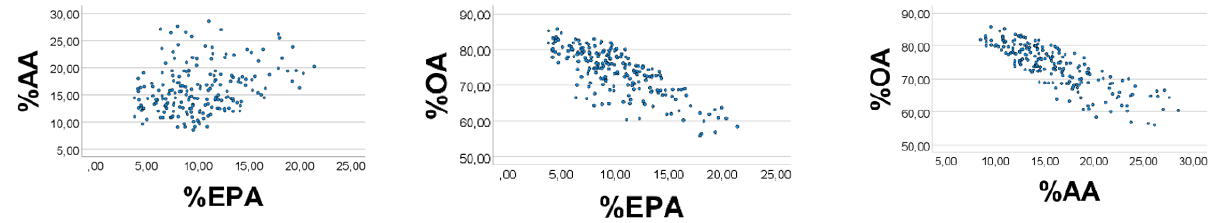
Figure 4. Effect of narrowing the OA ’ range, and broadening ranges of EPA ’ and AA ’ , upon associations between their relative amounts, in a computer experiment. S = OA ’ + EPA ’ + AA ’ . RANDOM numbers ( n = 200) were used in lieu of true values. Ranges of EPA ’ , AA ’ , and OA ’ were 0.1–0.4, 0.3–0.5, and 1–3, respectively. %EPA ’ vs. %AA ’ : rho = 0.697; %OA ’ vs. %EPA ’ (%AA ’ ): rho = −0.852 (−0.964), p < 0.001 for all. Note: In the figure we have omitted the random number mark ( ‘ ) on the variables.